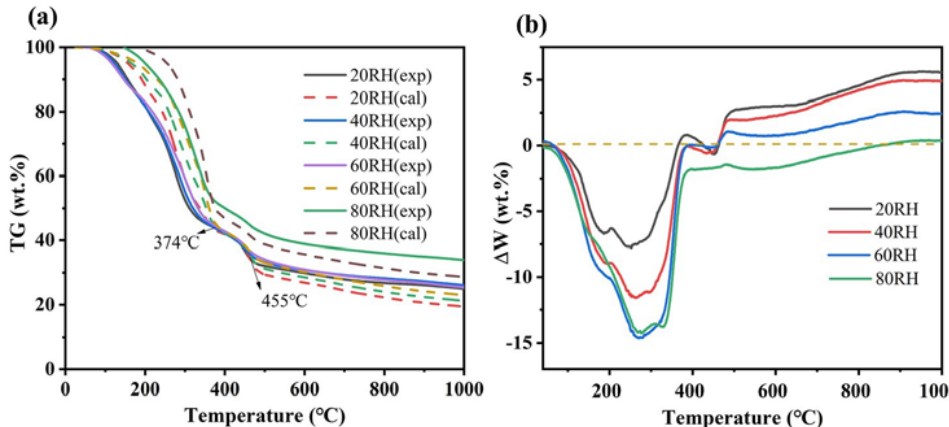
Figure 3. The comparison ( a ) and deviation ( b ) of experimental and calculated TG curves.